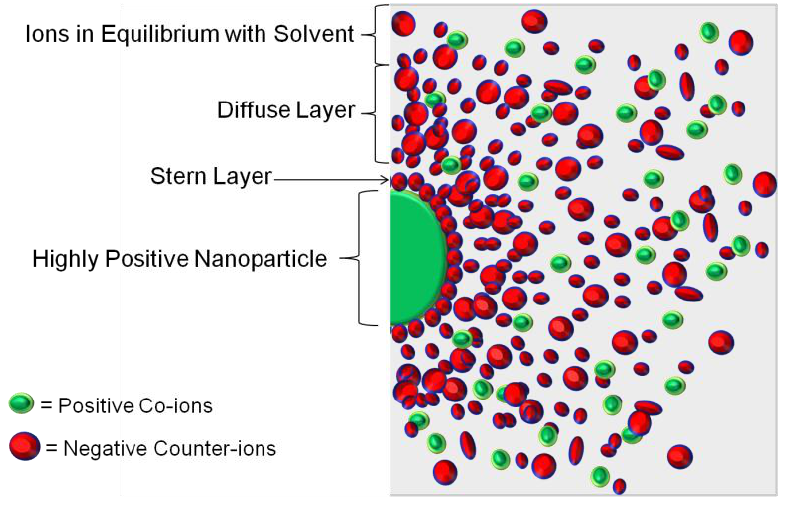
Figure 2. Electrical double layer distribution of